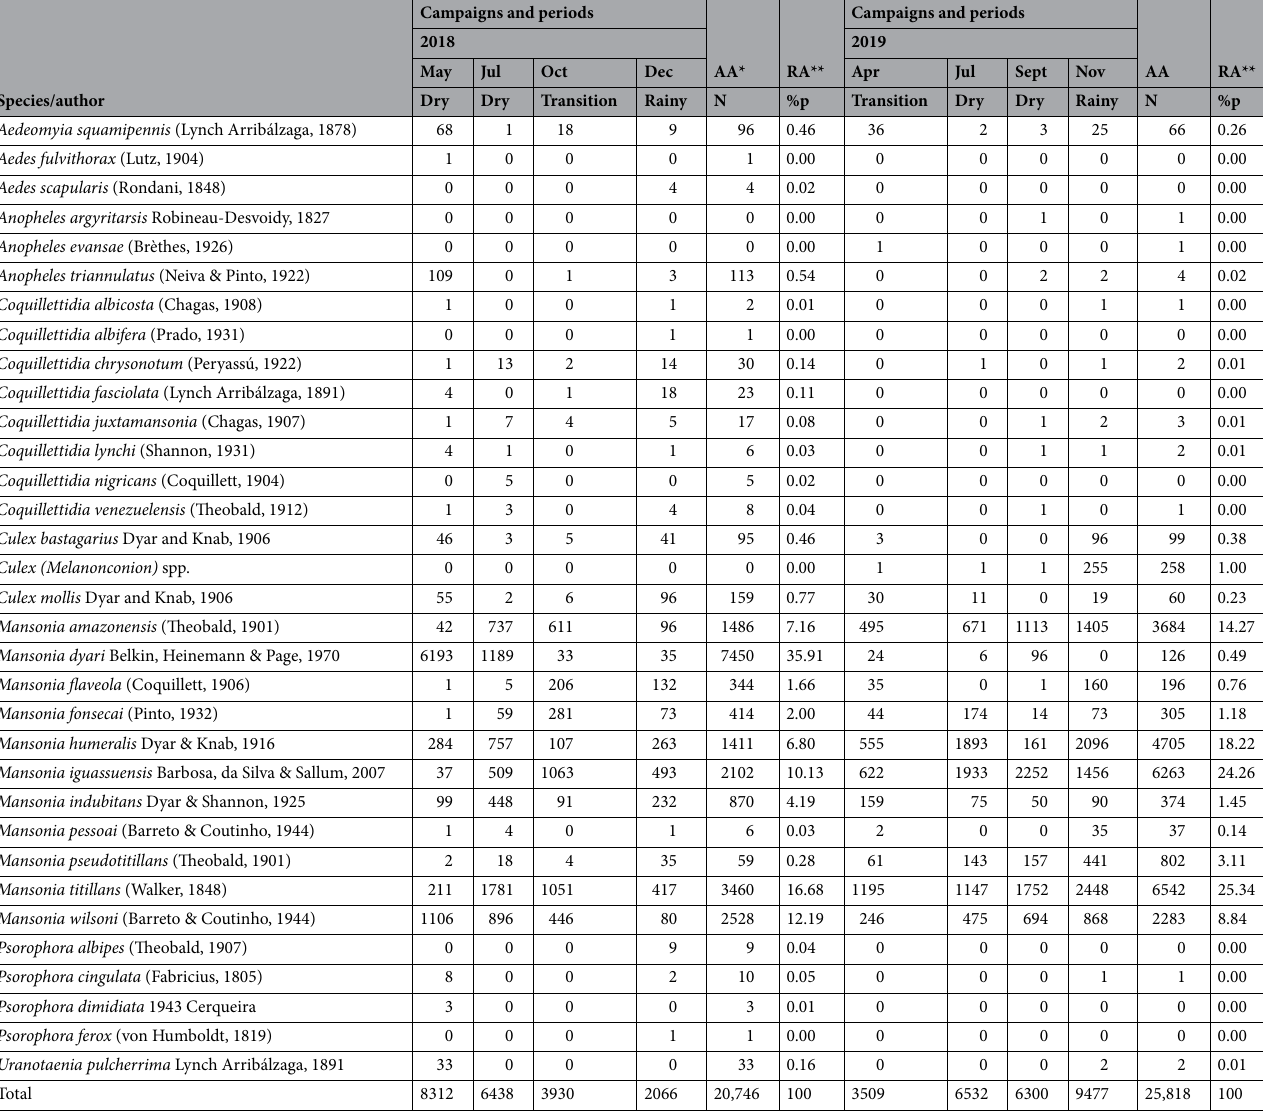
Table 1. Absolute and relative abundance of Culicidae adults captured in areas surrounding the Jirau hydroelectric power plant in Rondônia state, Brazil, in May, July, October, and December 2018 and April, July, September, and November 2019. * Absolute abundance. * * Relative